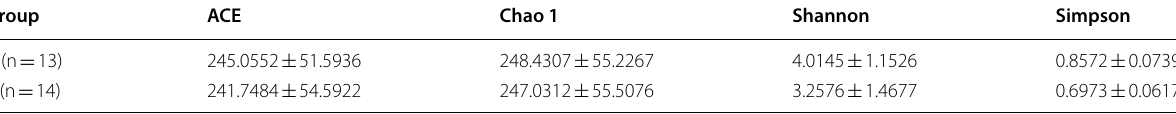
Group A control; Group B basal diet 0.5% Astragalus = = + a,b Different superscript letters in the same column indicate significant